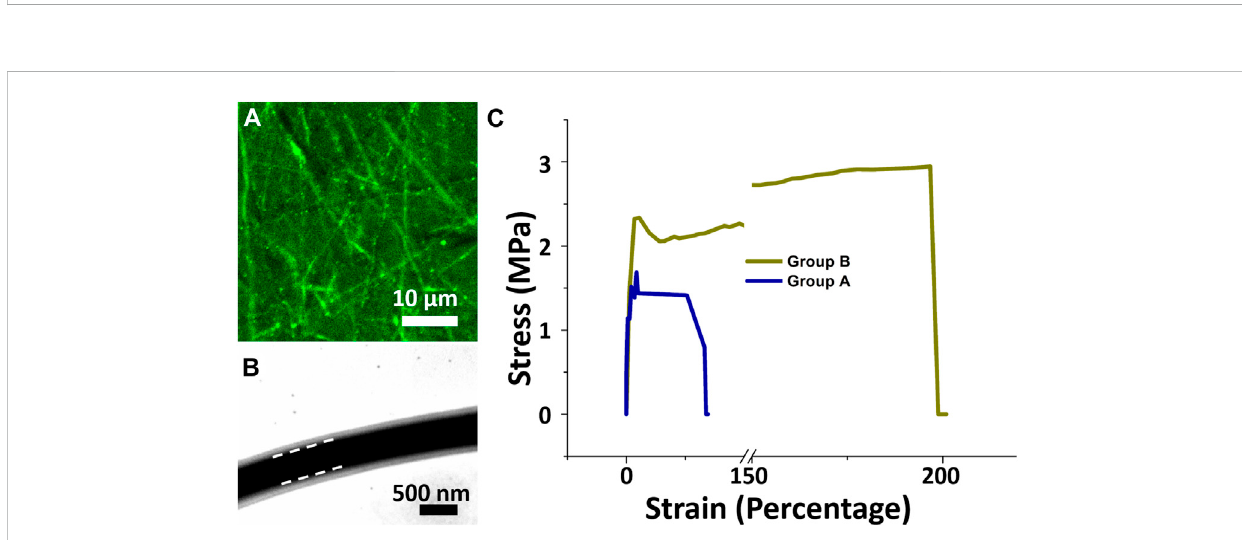
FIGURE 2 Laser scanning confocal microscopic and transmission electron microscopic images. Core-shell nano fi bers with reGFP as core and PLGA as shell werefabricated (A) .Core-shellnano fi brousscaffoldswithliquidsolutionbetweenwhitedashedlines (B) .Stress-straincurvesofcore-shellofbothgroups (C) . Stress (MPa) and percentage strain in group A were less than in group